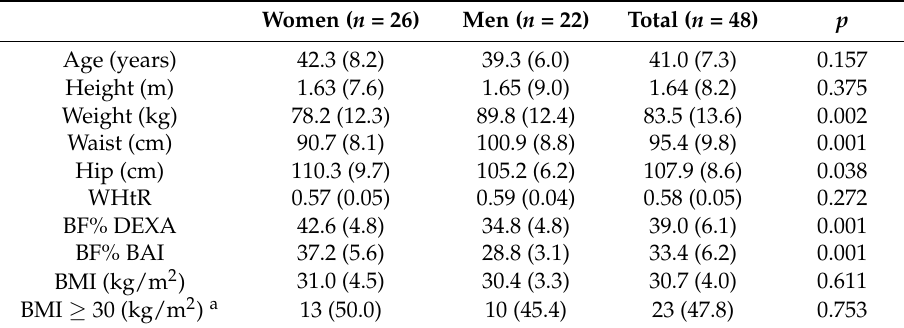
Table 1. Characteristics of study subjects as a whole and by